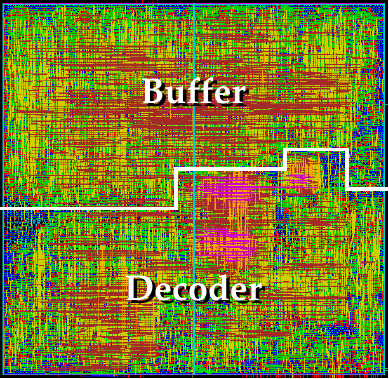
Figure 7. Chip layout of the proposed η = 4 LCC